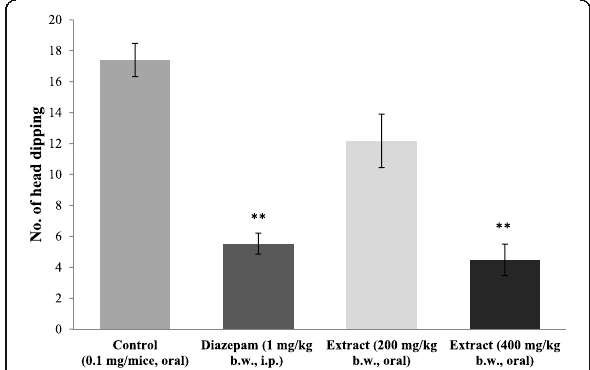
Fig. 3 Influence of the ethyl acetate extract of D. malabarica seeds in hole board test using mice